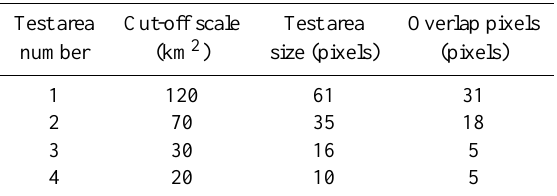
Table 3. Properties of the four test areas used in the computation of the